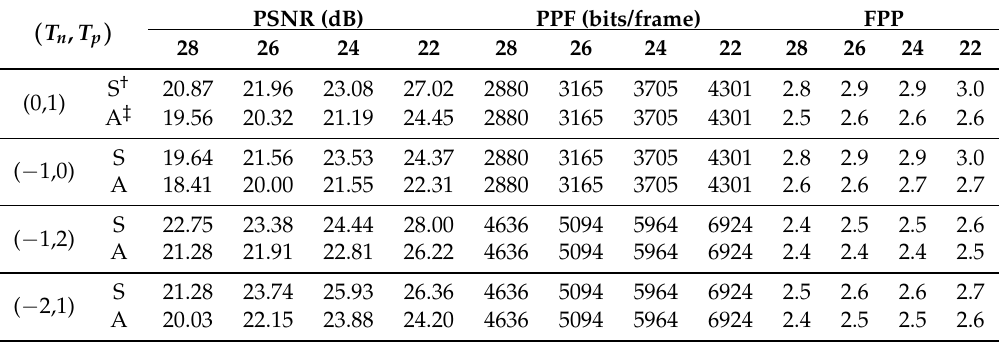
Table 2. The performance comparison between symmetric and asymmetric histogram shifting.